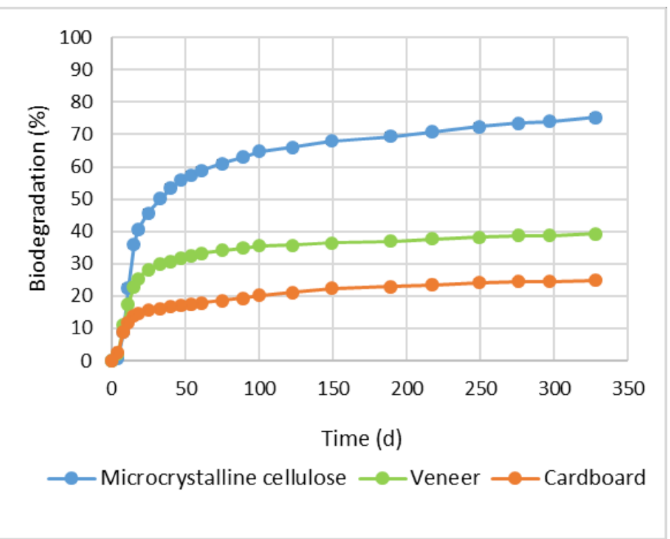
Figure 6. Biodegradation of uncoated veneer and cardboard in soil conditions. Biodegradation is calculated as ratio of measured CO 2 and theoretically produced CO 2